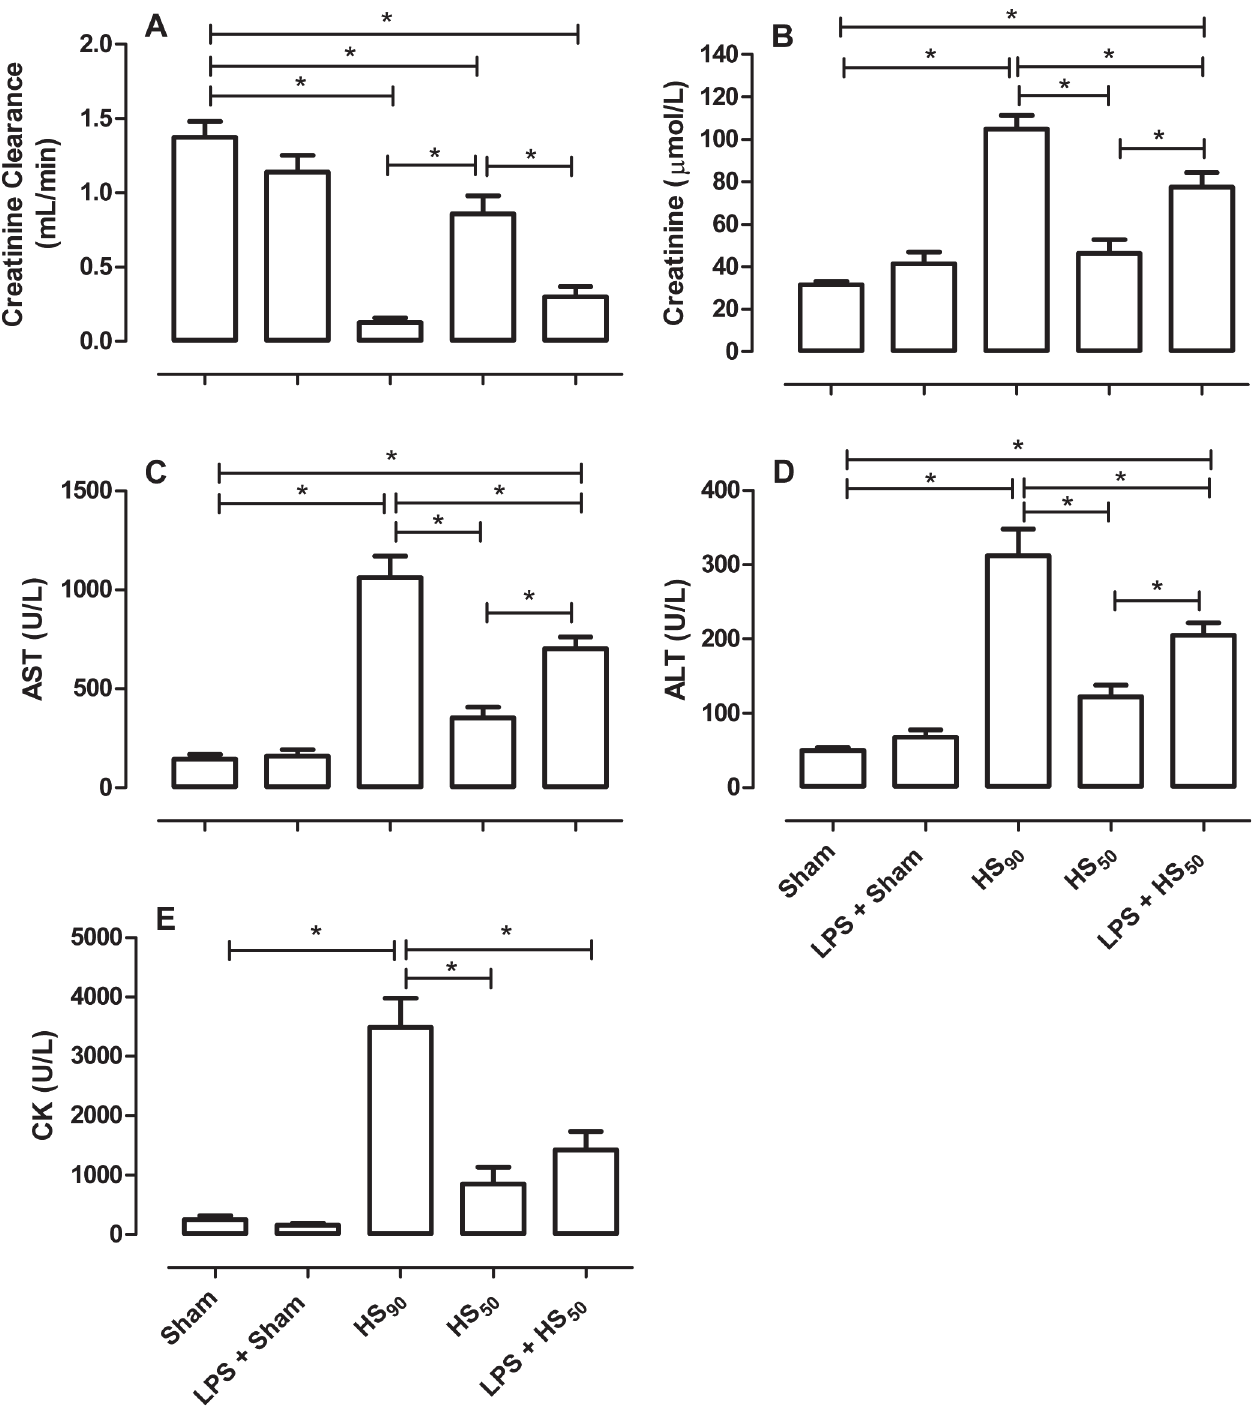
Fig 1. Effect of LPS preconditioning on multiple organ dysfunction induced by HS. Rats were injected vehicle (PBS) or LPS (1 mg/kg) i.p. 24 h prior to HS 90 or HS 50 . Four hours after resuscitation the (A) creatinine clearance as a measure of glomerular function; (B) serum creatinine level as a measure of renal function; (C) serum aspartate aminotransferase (AST) and (D) serum alanine aminotransferase (ALT) as a measure of liver injury; and (E) serum creatine kinase (CK) level as a measure of neuromuscular injury were determined. Sham animals were used as control. Data are expressed as mean ± SEM of 8 – 10 animals. Statistical analysis was performed using one-way ANOVA followed by Bonferroni ’ s post hoc test. * p < 0.05 among the groups.